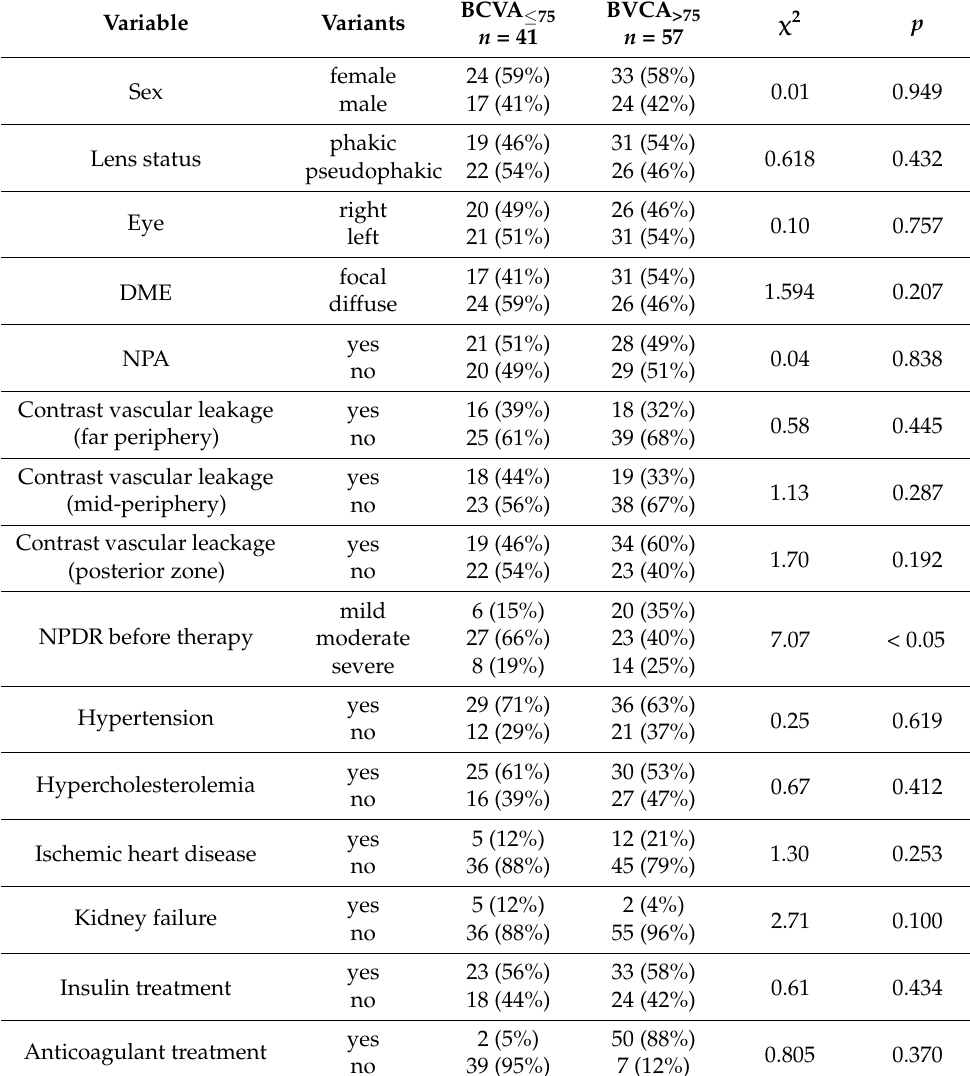
Table 2. Diabetic retinopathy qualitative variables of patients with diabetic macular edema (DME) qualified for the study described as unsatisfactory (BCVA ≤ 75 , n = 41) or satisfactory (BCVA >75 , n = 57) responders to the intravitreal bevacizumab treatment. The data were compared using chi-squared ( χ 2 ) test. Statistical significance was set at p <